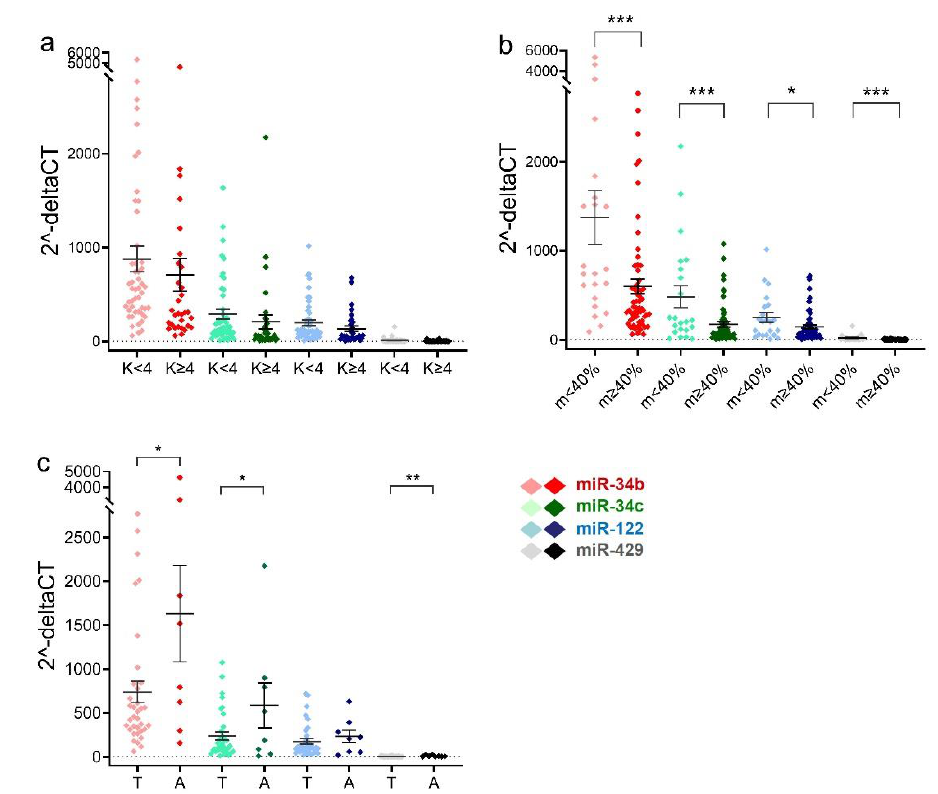
Figure 2. Relative expression levels of miRNAs in spermatozoa with differential morphology and motility. ( a ) Scatter plot showing sperm relative levels of miR-34b/c, miR-122, and miR-429 of each man in the K < 4 and K ≥ 4 groups. Kruger value (K) serves as a criterion for identifying sperm morphology. * p < 0.05. K < 4, n = 49; K ≥ 4, n = 32. ( b ) Scatter plot showing sperm relative levels of miR-34b/c, miR-122, and miR-429 for each individual in motility m < 40% and ≥ 40 groups. m < 40%, n = 22; m ≥ 40%, n = 59. * p < 0.05, *** p < 0.001. ( c ) Differential relative levels of miR-34b/c, miR-122, and miR-429 between spermatozoa from teratozoospermia-only ( n = 35) and asthenozoospermia-only ( n = 8) men. The data are shown as mean and SEM. A, asthenozoospermia; T, teratozoospermia. * p < 0.05, ** p < 0.01.